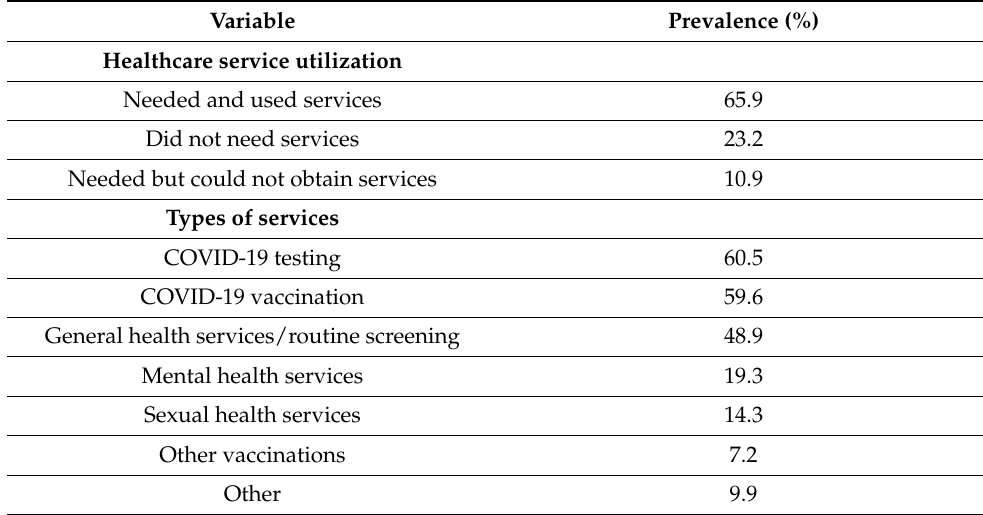
Table 2. Prevalence of healthcare utilization and types of